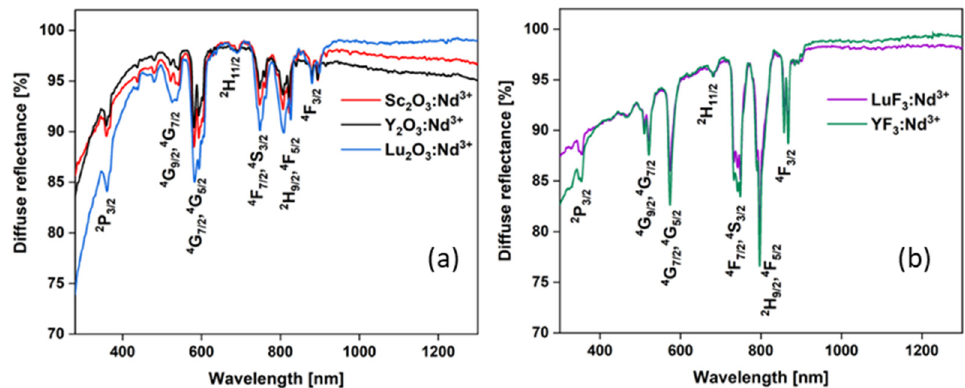
Figure 2. Diffuse reflection spectra of ( a ) 3%Nd:Y 2 O 3 , 3%Nd:Lu 2 O 3 , and 3%Nd:Sc 2 O 3 , and ( b ) 5%Nd:YF 3 and 5%Nd:LuF 3 .